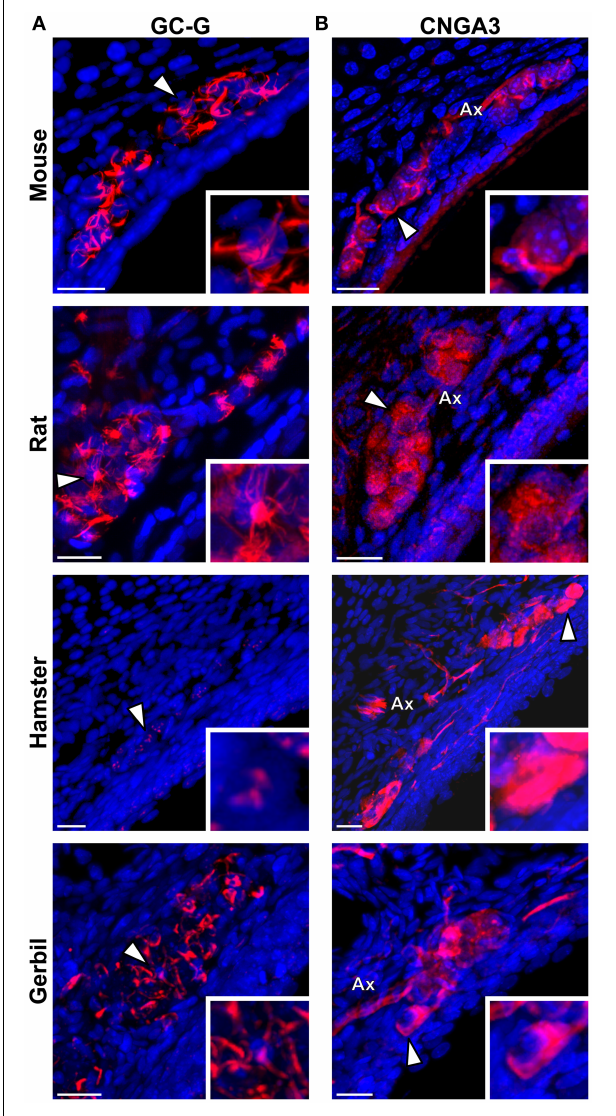
FIGURE 5 | Species-dependent expression of cGMP-associated signaling proteins in the rodential Grueneberg ganglia. Immunohistochemical investigations performed for GC-G and CNGA3 proteins in GG coronal slices from mouse, rat, hamster, and gerbil. (A) GC-G was found in mouse, rat, and gerbil GGn cilia. Residual expression was observed in hamster. (B) CNGA3 was found principally in GGn cilia and axon (Ax) with partial somatic expression in mouse, while in the other rodents widespread expressions were detected. (A,B) White arrowheads indicate the neuron illustrated in the high power view inset. A minimum of 3 animals (mouse: from P1 to P26; rat: from P3 to P29; hamster: from P2 to P16; gerbil: from P1 to P30) and 6 slices were used for each staining and species. Nuclei are shown in blue (DAPI counterstain). Scale bars, 20 μ